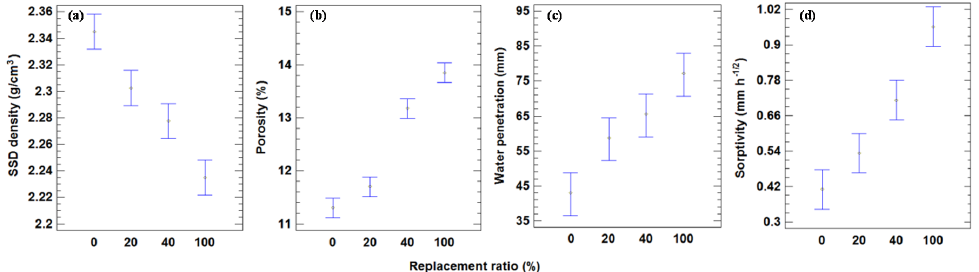
Figure 9. ( a ) Mean values of SSD density and 95% LSD intervals vs. replacement ratio. ( b ) Mean values of porosity and 95% LSD intervals vs. replacement ratio. ( c ) Mean values of water penetration and 95% LSD intervals vs. replacement ratio. ( d ) Mean values of sorptivity and 95% LSD intervals vs. replacement ratio.